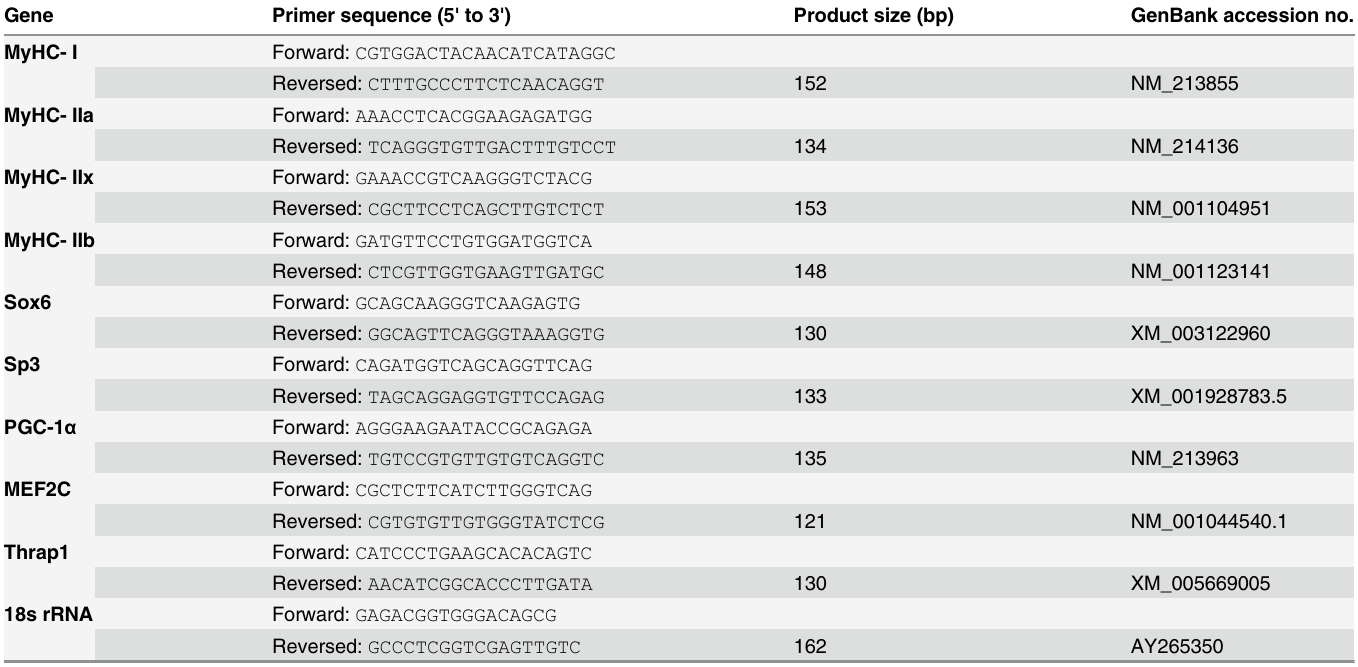
Table 3. Sequences used for real-time PCR primers. Gene Primer sequence (5' to